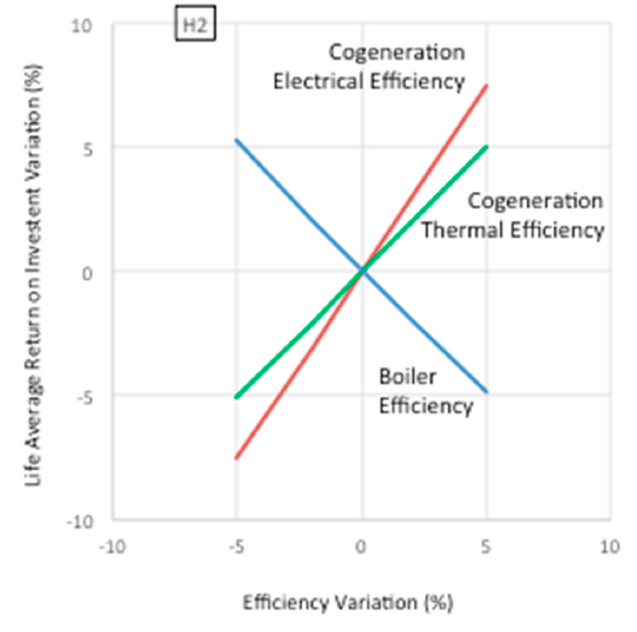
Figure 7. Life average return on investment ( ROI T ) of project H2, for +/ − 5% variation of electrical, thermal, and boiler e ffi ciency of the